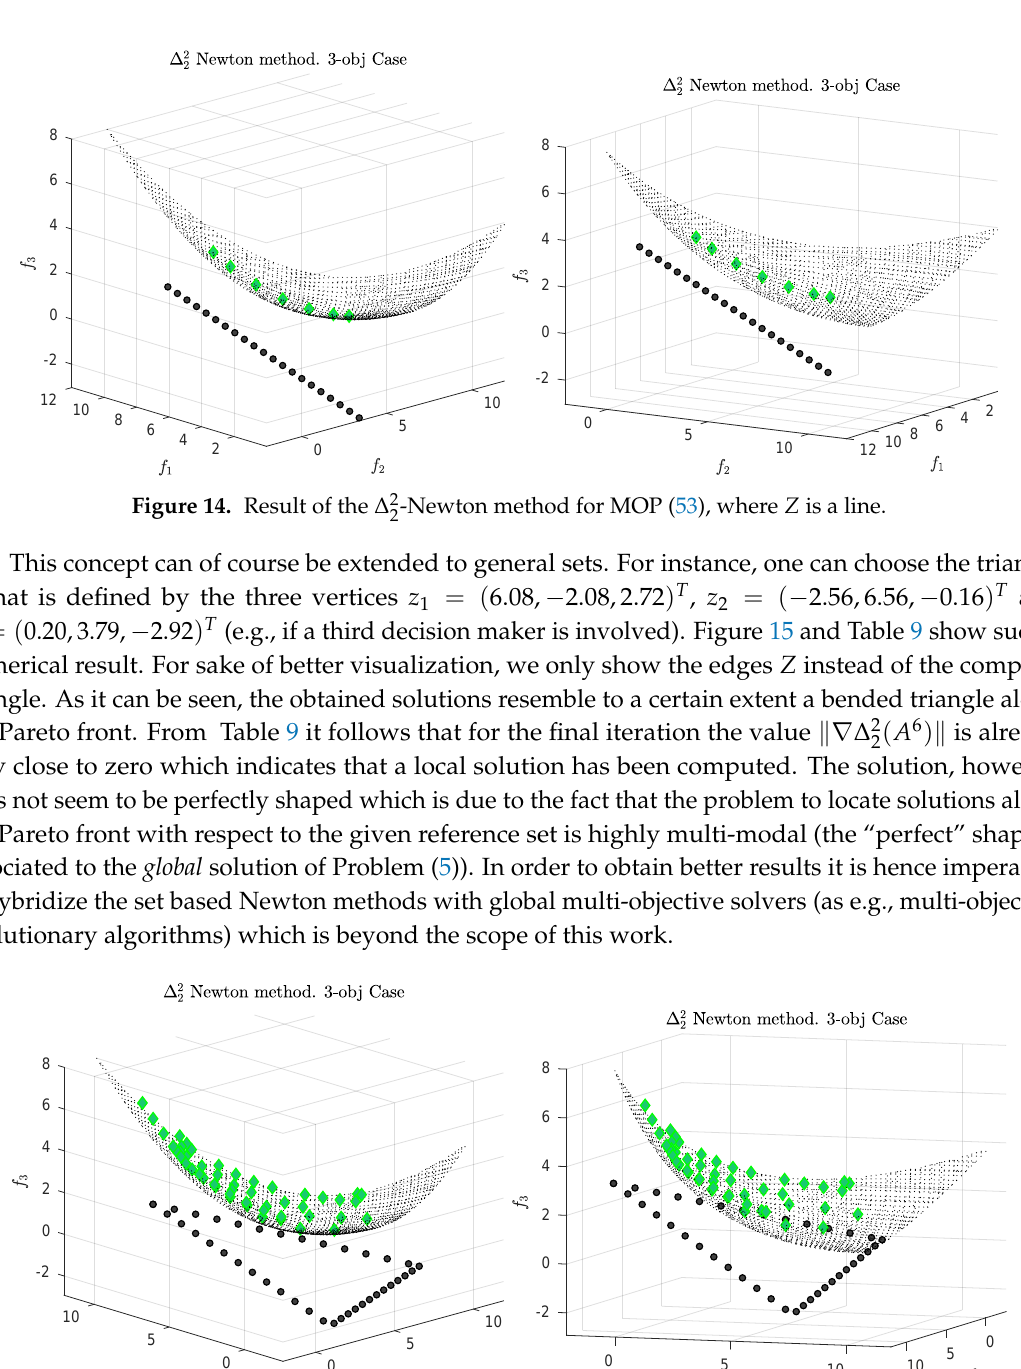
Figure 15. Result of the ∆ 2 -Newton method for MOP (53), where Z is a triangle (two different views 2 of the same